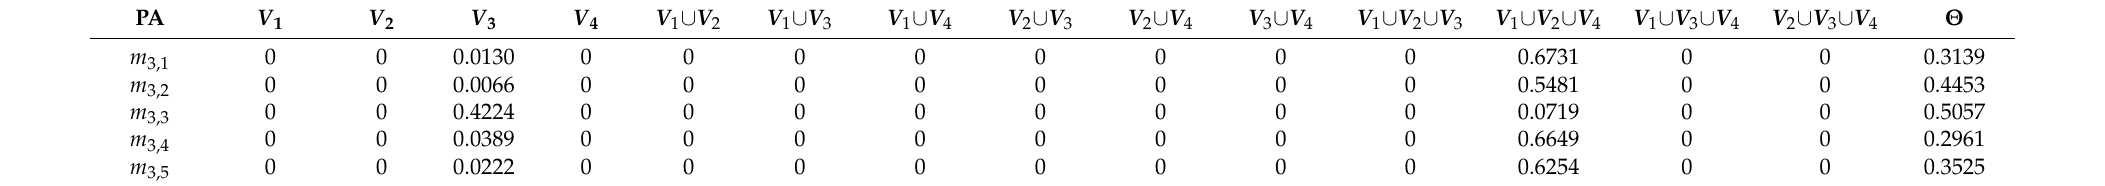
Table 4. Probability assignments of transverse crack-rest sub-classifier for an image without a crack.